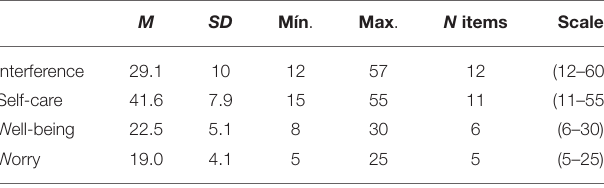
TABLE 5 | Descriptive analysis of the ViDa1 according to subscale. ( N = 578).